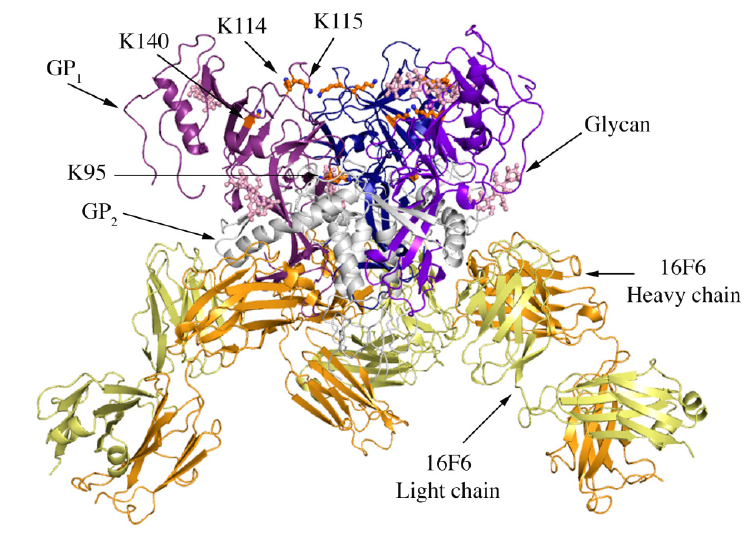
Figure 1. Cartoon representation of trimer of SUDV-Bon GP chains are colored in various shades of blue and GP chain of 16F6 is shown in pale yellow and the heavy chain of 16F6 is colored bright orange. The sugar residues on the glycoprotein are shown in ball and colored cyan. Lysine residues critical for receptor binding are shown in ball and stick and colored